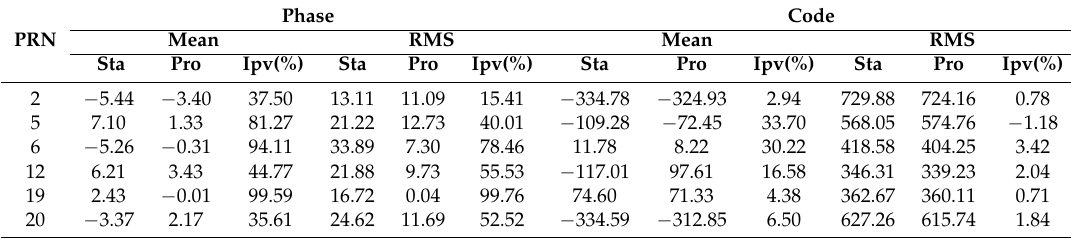
Table 2. Means and RMSs of the phase and code residuals of the satellites being identified with model error during Event 1. The unit is mm . The abbreviations Sta and Pro represent the standard and proposed PPP approaches, respectively, and Ipv represents the improvement of the proposed approach compared to the standard